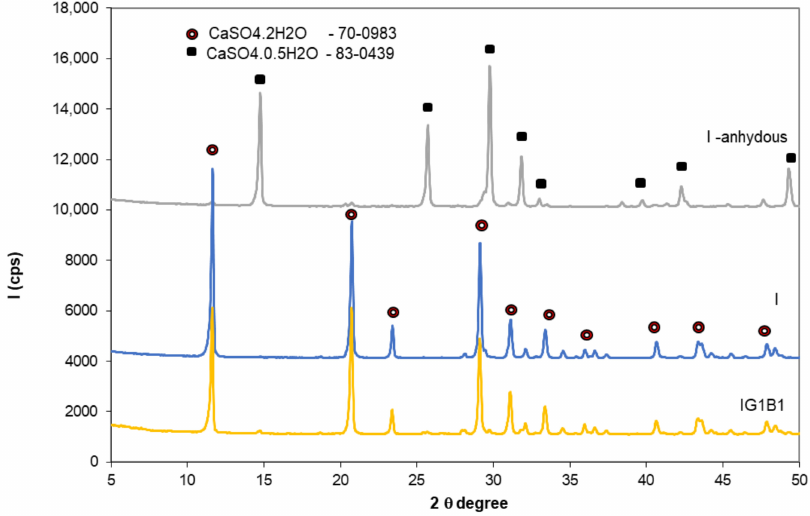
Figure 10. XRD patterns of gypsum binder I—anhydrous and I and IG1B1 hardened